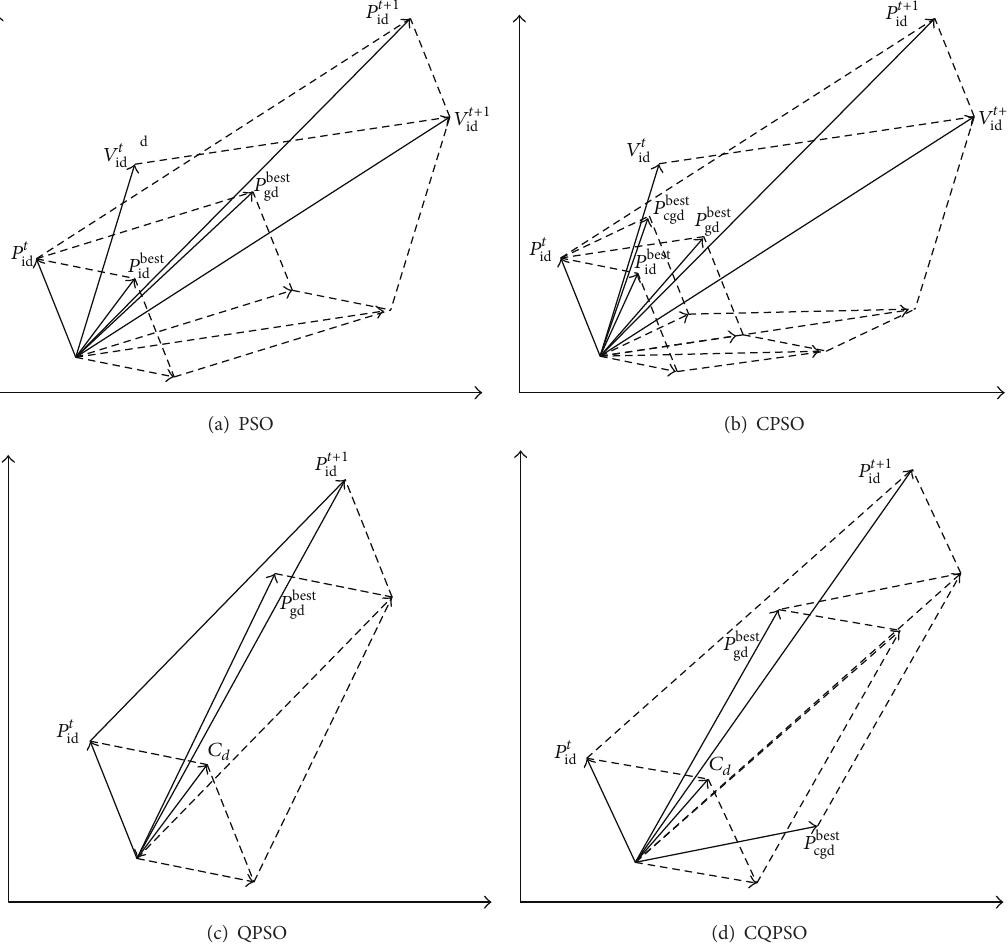
Figure 1: Particle movement principle of PSO, CPSO, QPSO, and